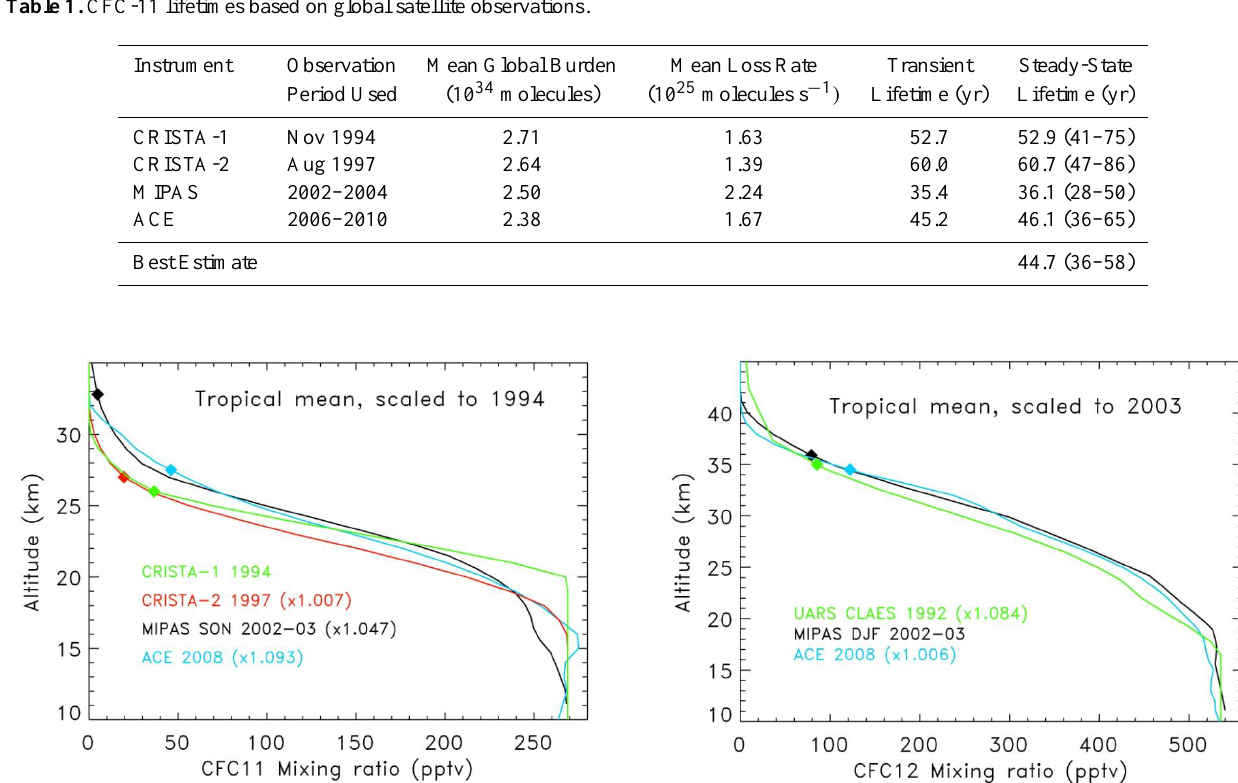
Fig. 7. Same as Figure 6, but plotted are tropical mean vertical profiles of CFC-12 mixing 641 Fig. 7. Same as Fig. 6, but plotted are tropical mean vertical pro- ratio from UARS CLAES (green), MIPAS (black), and ACE (blue), all scaled to a 642 files of CFC-12 mixing ratio from UARS CLAES (green), MIPAS tropospheric mean mixing ratio of 542 ppt using altitude independent factors. 643 (black), and ACE (blue), all scaled to a tropospheric mean mixing ratio of 542ppt using altitude-independent